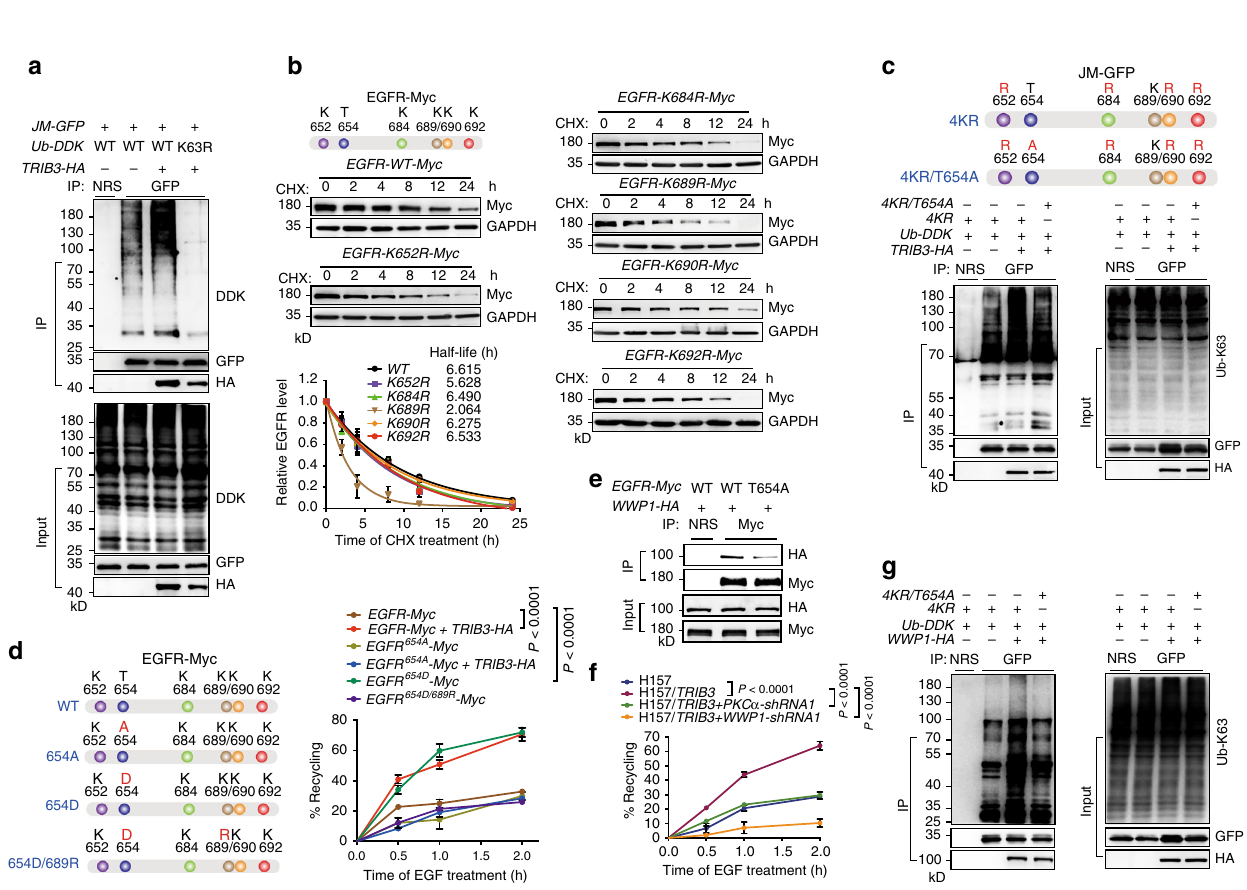
Fig. 3 TRIB3 interacts with EGFR to promote PKC α -mediated EGFR phosphorylation. a Interactors of TRIB3 were screened through a human protein microarray (HuProt TM 20 K) with puri fi ed TRIB3 protein. Data shown are signal to noise ratio (SNR) values and representative images of PKC α . Alexa647- labeled IgG and Biotin-labeled BSA were used as positive controls. GST protein, the buffer only and BSA were used as negative controls. Two repeats were designed for each protein of the microarray. b , c TRIB3, EGFR and PKC α form heterotrimeric complex. Protein extracts from A549 cells were IP with anti- TRIB3, anti-EGFR or anti-PKC α Abs individually, and detected with indicated Abs ( b ). Primary NSCLC cells were treated with EGF (100 ng ml − 1 ) for 30 min. Colocalization of EGFR with PKC α and TRIB3 was analyzed with confocal microscopy ( c ). d Confocal microscopy images show the colocalization of EGFR with PKC α in control and TRIB3 -silenced A549 cells treated with EGF (100 ng ml − 1 ) for 30 min. Quanti fi cation of EGFR and PKC α colocalization was shown as Pearson ’ s coef fi cient. Data are means± SEM of three independent assays. e Control and TRIB3 -silenced A549 cells were transfected with indicated plasmid and treated with or without EGF (100 ng ml − 1 ) for 1 h. EGFR T654 phosphorylation was detected by IB. f Mapping TRIB3 regions involved in EGFR binding. Left: schematic diagram of TRIB3 deletion mutants. Right: HEK 293T cells were cotransfected with indicated constructs of EGFR-Myc and TRIB3-HA deletion mutants. Cell extracts were IP with anti-Myc Ab. g Mapping TRIB3 regions involved in PKC α binding. h Mapping EGFR regions involved in TRIB3 binding. i Mapping the domains of ICD region involved in TRIB3 binding. j The recycling of EGFR was determined by ELISA in A549 cells with the indicated constructs stably expressed. Data represent mean ± SEM of three assays. Data in e – i are representatives of three independent assays. Statistical signi fi cance was determined by one-way ANOVA test. (KD kinase-dead region, KDN N-terminal of KD, KDC C-terminal of KD, ECD extracellular domain, ICD intracellular domain. JM juxtamembrane, TK tyrosine kinase, CT C-terminal, TRIB3 si-Ris the TRIB3-siRNA -resistant expressing plasmid). Source data are provided as a Source Data fi le.